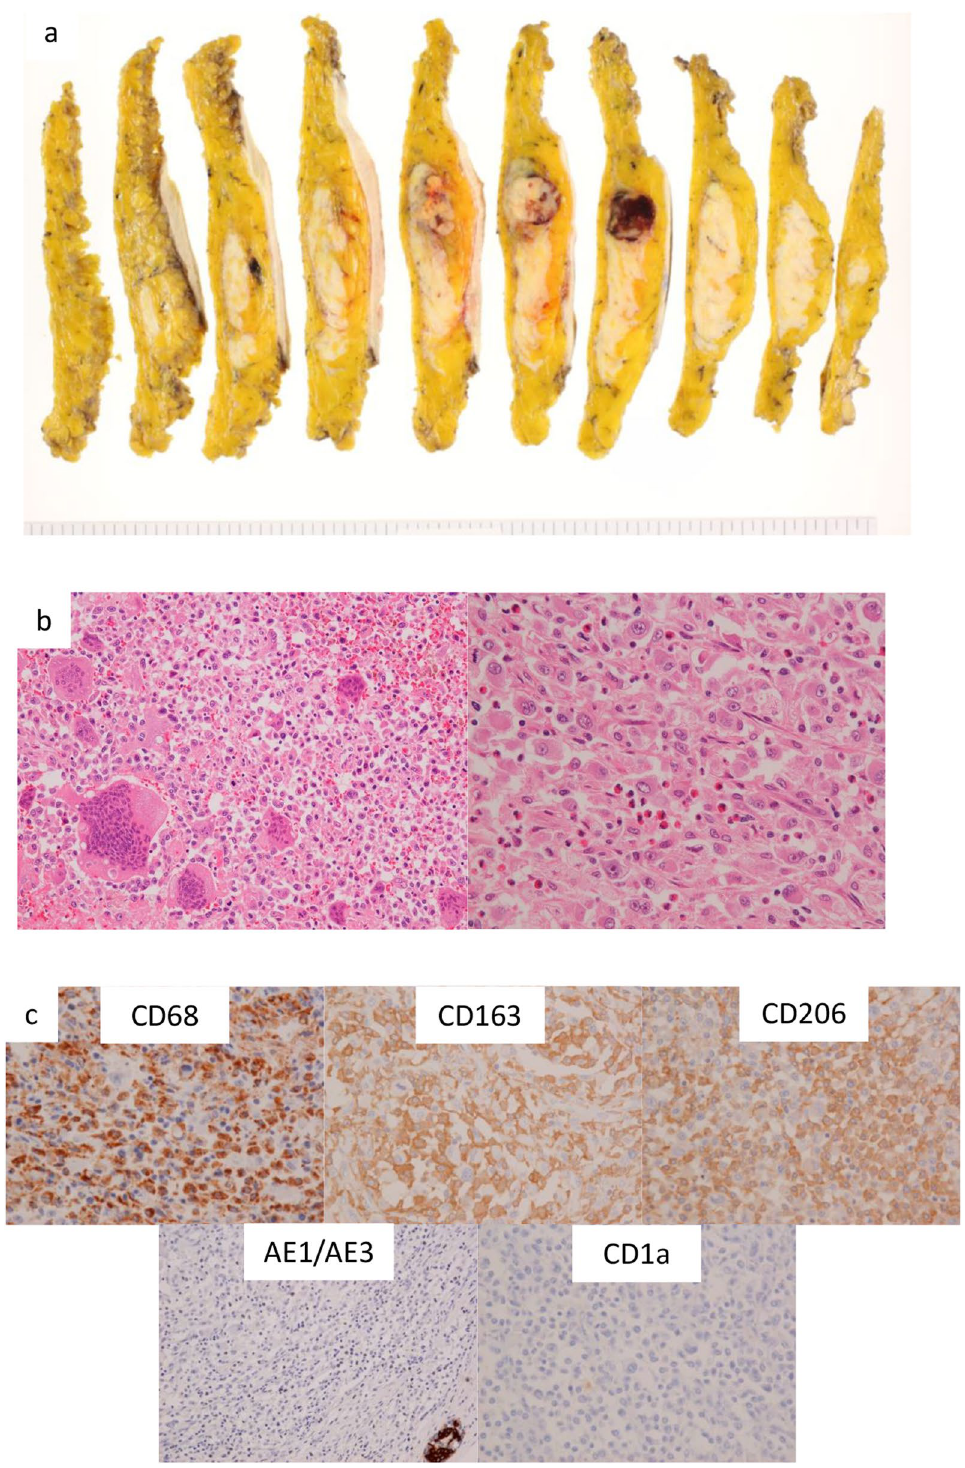
Fig. 2 Characterization of the breast lesion. a Macroscopic finding. Round lesion showing well‑defined margin, focal necrotic tissue, and bleeding. b Hematoxylin and eosin stain (HE), 40. Proliferation of large, epithelioid cells with bizarre pleomorphic nuclei and abundant cytoplasm. HE, × Prominent multinucleated giant cells showed scattered lymphocytes and eosinophils in the background. c Immunohistochemical panel. CD68, positive; CD163, positive; CD206, positive; AE1/AE3, negative; CD1a,